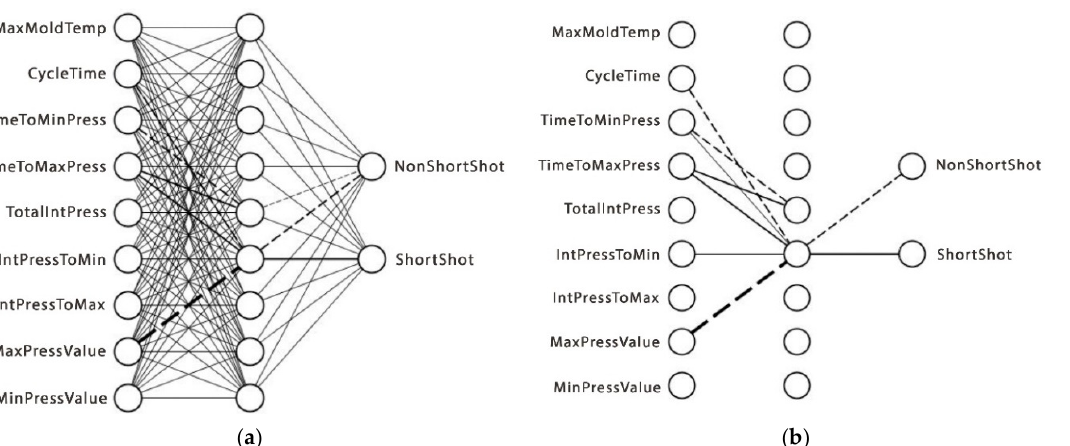
Figure 6. The mean squared error of ANN training using backpropagation and SLF. To assess the validity of the proposed approach, the performance evaluation of the two ANN models was furtherly compared. The evaluation criteria previously outlined in Section 2.4 were applied to both models. For evaluation purposes, the models were run to predict the test dataset which consists of 90 data. The first performance comparison is the confusion matrix as depicted in Figure 7. From Figure 7, we can see that there is no signif- icant distinction between the confusion matrix of the ANN model trained with the back- propagation algorithm (see Figure 7a) and the ANN model trained with the SLF approach (see Figure 7b). The ANN model trained with the SLF algorithm made 6 errors (FP + FN) out of 90 predictions.